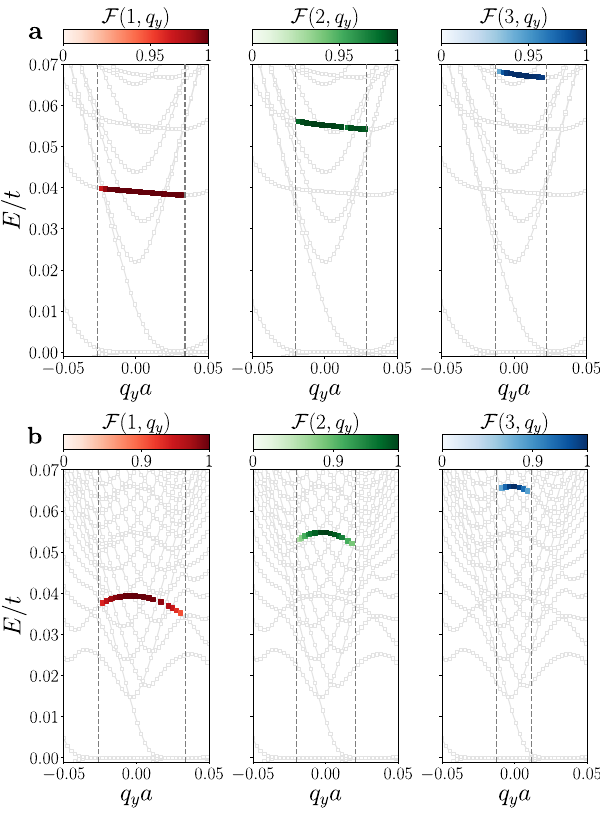
around the K Fig. 9 Landau levels wavefunction fi delity. Spectra of ^ H eff # point obtained ( a ) in the Thomas – Fermi regime and ( b ) in the non- interacting regime, where we superimpose the fi delity F ð ν ; q y Þ with the Landau level eigenstates computed in a range of momenta delimited by the vertical dashed lines. Each panel addresses the fi delity of the ν th Landau level. The parameters for the two regimes are chosen as in the previous plots. For a , the number of sites along x is N x = 601, the onsite interaction is U = 10 − 4 J , the strength of the harmonic trap is V x = 10 − 6 J / a 2 , the number of condensed bosons is N ↑ = 1.2 × 10 5 , and the interspecies interaction strength is α = 0.3. For b , N x = 1401, V x = 5.8 × 10 − 11 J / a 2 , N ↑ = 4.8 × 10 5 and α = 0.49. As the fi delity is calculated for bulk state, the range of momenta has been chosen to avoid interface or edge states effects.